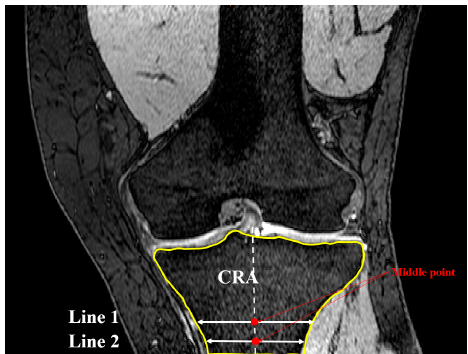
Figure 7. Definition of the second line parallel and 10 mm distal to line 1 in CRS and therein defining CRA (coronal view).